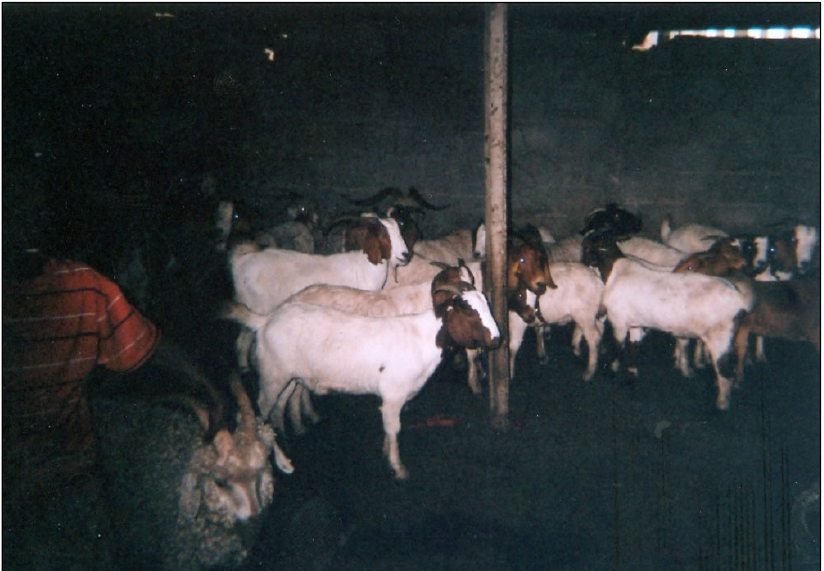
Plate 1. Livestocking in KwaMashu: Goats Purchased Transported